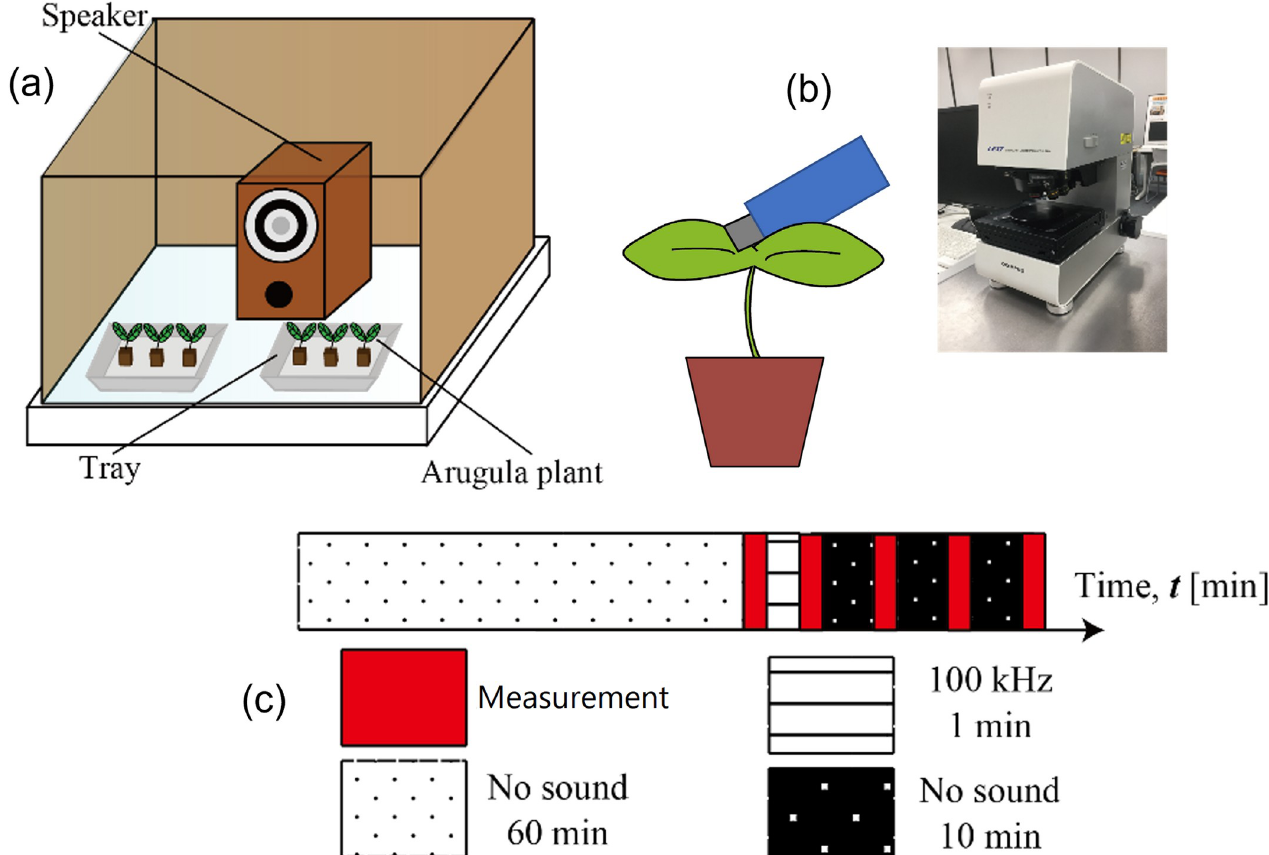
Fig 4. Plants placed in a soundproof chamber (a) followed by observation of a leaf teared off from the plant by OLS4000 with the sound exposure protocol shown in (c).